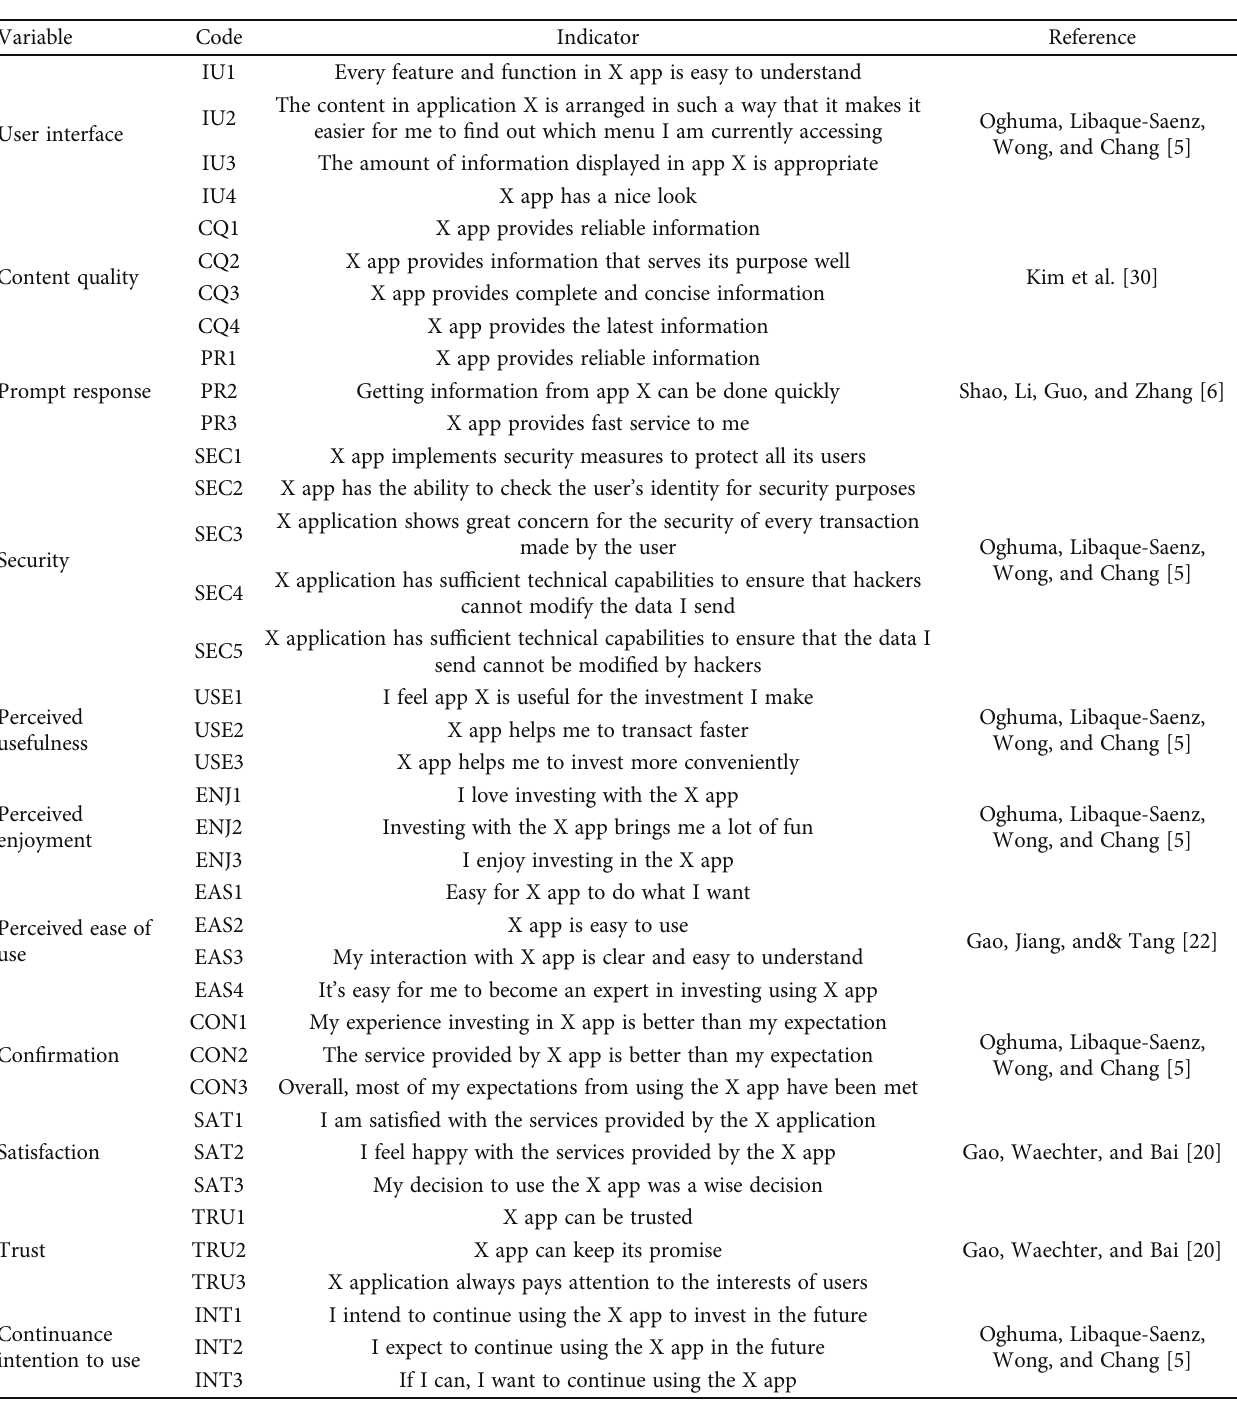
Table 1: Measurement